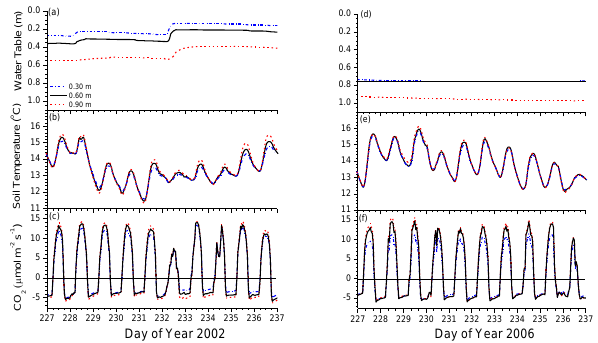
Fig. 10. Changes in water table depth, soil temperatures at 0.12m, and CO 2 fluxes modelled from DOY 228 to 237 in 2002 and 2006 by raising or lowering the depth of the external water table from 0.6m (Fig. 1) to 0.3 m or 0.9m. CO 2 fluxes modelled at 0.6m are the same as those in Fig. 4.